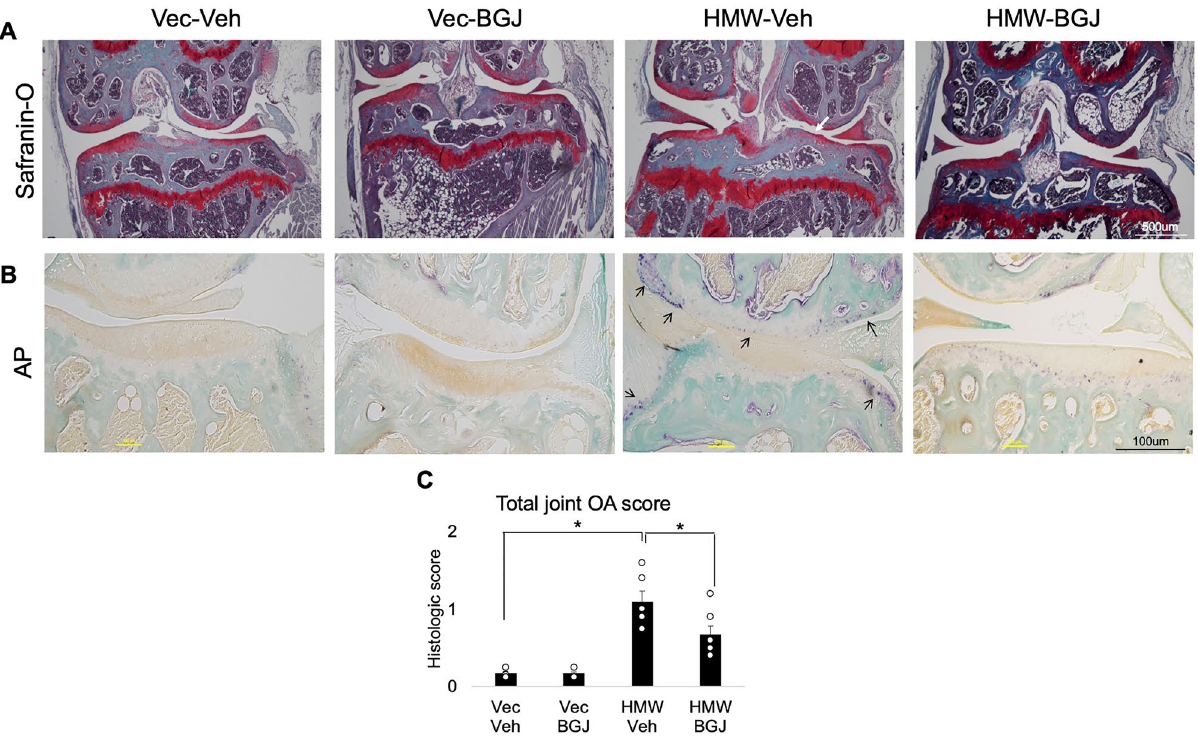
Figure 3. Histomorphometric analysis of knee articular cartilage of Vector-Control and HMWTgFGF2 mice treated with BGJ398. ( A ) Safranin-O-stained representative images of knee joint. Eight-month-old Vector- Control (Vec) and HMWtgFGF2 (HMW) female mice were sq injected with vehicle or BGJ398 5 days/week for 6 weeks. At the end of the experiment (9.5 months old), knee joints were collected for histology analysis. Safranin-O staining showed a dramatic decrease in proteoglycan content and erosion of cartilage surface in HMWTgFGF2 knees (white arrow), which was partially reversed by BGJ398 treatment. ( B ) Alkaline phosphatase staining of a representative knee joint. Six and a half-month-old Vector-Control and HMWTgFGF2 male mice were sq injected with vehicle or BGJ398 5 days/week for 6 weeks. At the end of experiment (8-month-old) knee joints were collected for histology analysis. Alkaline phosphatase staining showed more alkaline phosphatase-positive articular chondrocytes in HMWTgFGF2 vehicle-treated joints (black arrows), that was partially normalized by BGJ398 treatment. Representative images from n = 4 mice/group. ( C ) Mean total joint OA scoring was performed using Safranin-O-stained samples. OA score was significantly increased in the HWTg vehicle group compared with the Vector-Control vehicle group, that was partially rescued by BGJ398 treatment. Data are shown as mean and individual points. n = 6 mice/group. *p < 0.05 by two-way